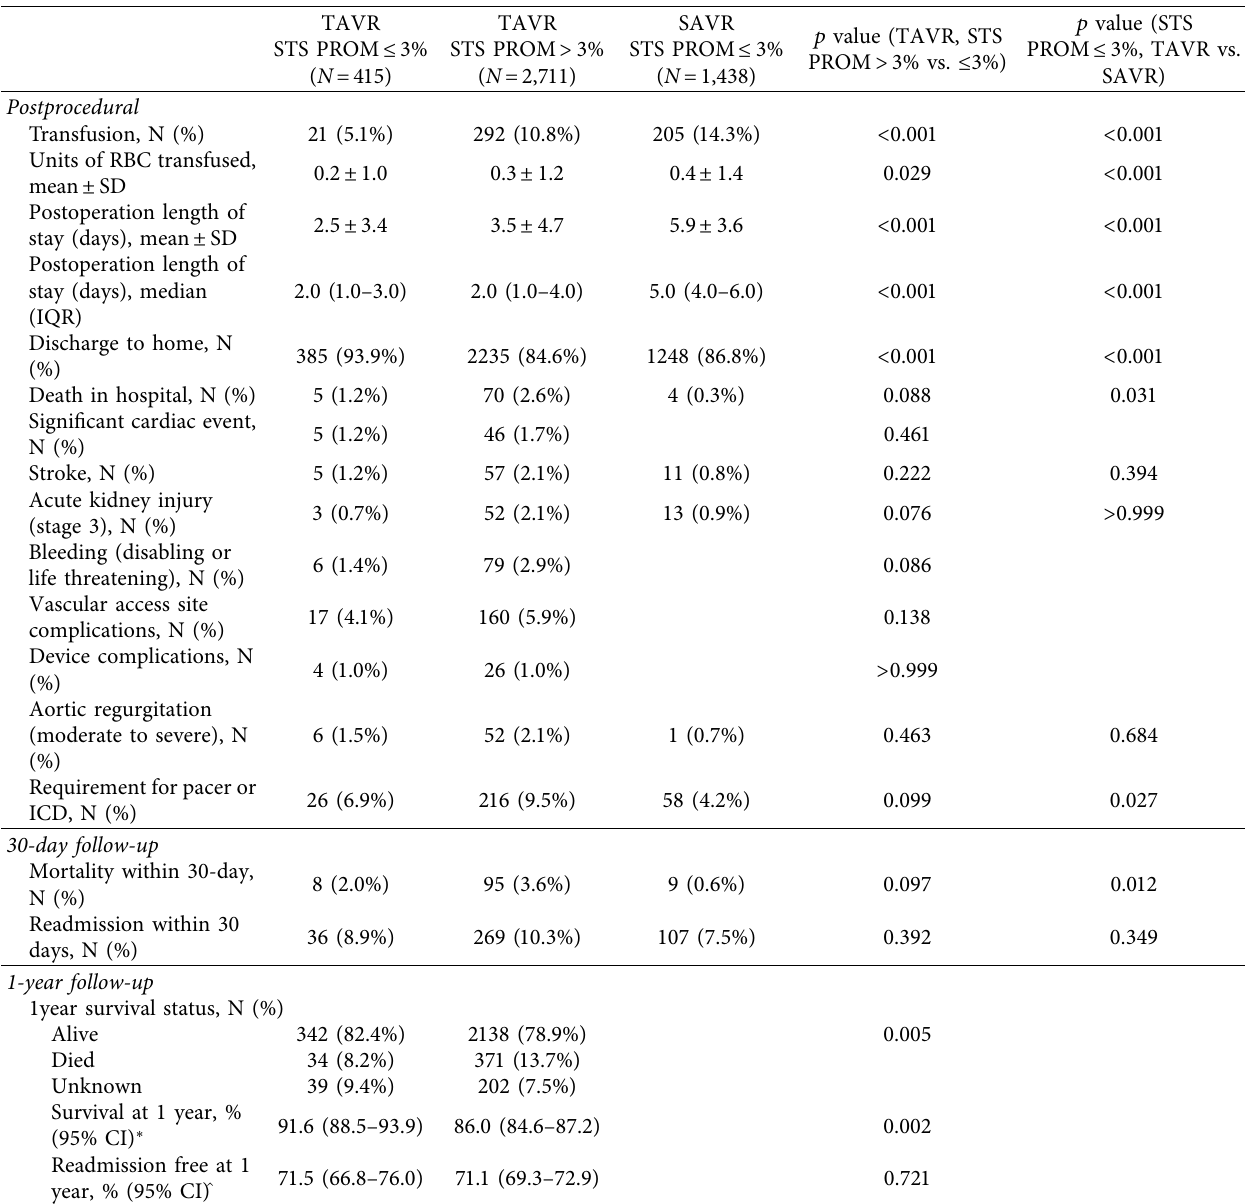
Table 4: Outcomes by study